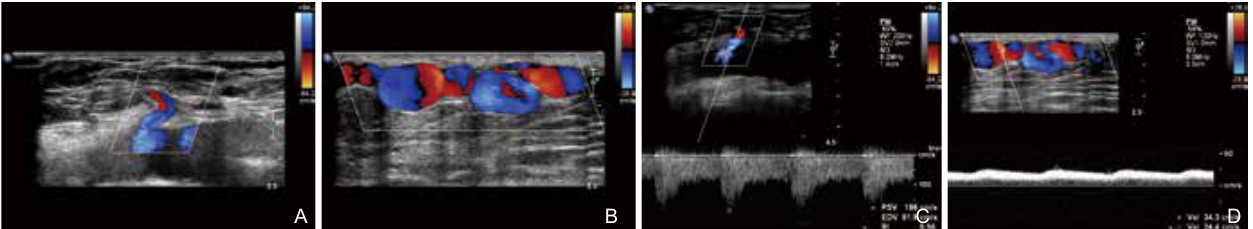
Figure 3 Color Doppler ultrasound demonstrated the primary vessel of the arteriovenous fistula (A). The abnormal vessel became large and tortuous in the subcutaneous tissues (B). The vascular malformations demonstrated gradual decreases in blood flow velocity and resistance index (C, D).